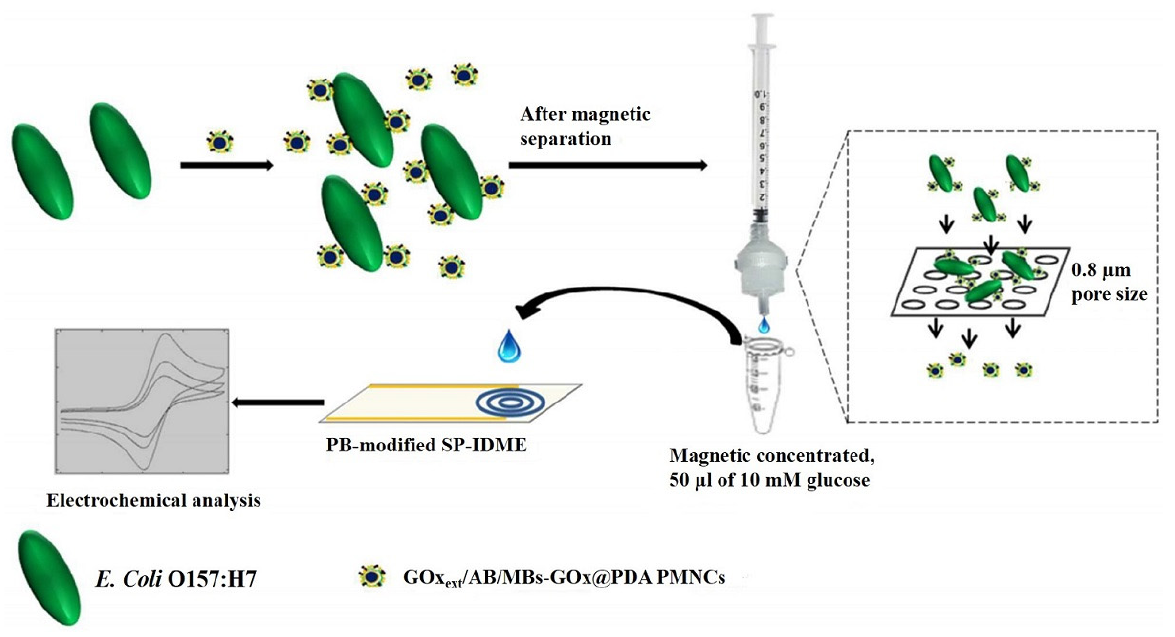
Figure 11. Electrochemical biosensor construction for E. coli O157:H7 detection (adapted and reprinted with permission from [152]).